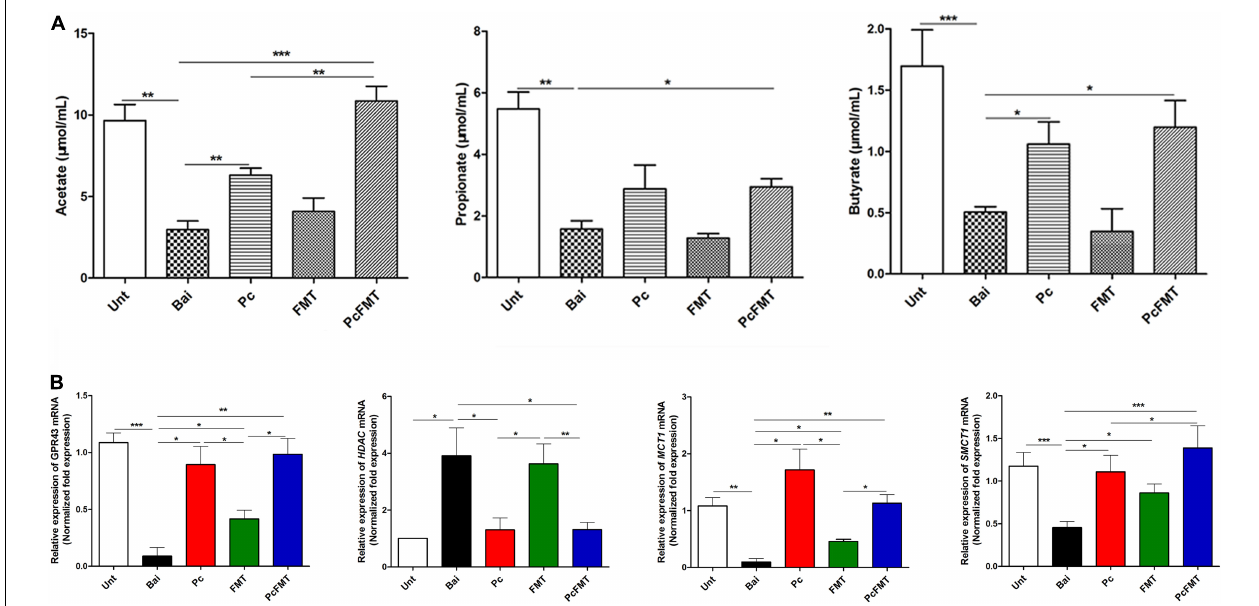
FIGURE 6 | SCFA concentrations and the relative expression of SCFA metabolism related genes. The colonic tissues and faeces were collected from healthy, bacterial-infected, single-dose Pc-treated, FMT-treated, and PcFMT-treated mice 48 h after S. Typhimurium (0.2 mL, 4 × 10 8 CFU/mouse) infection. (A) SCFA contents (acetate, propionate, butyrate) in the faeces of healthy, bacteria-infected, single-dose Pc-treated, FMT-treated, and PcFMT-treated mice. (B) The transcription levels of the SCFA transporters SMCT 1 and MCT 1 and the SCFA receptors HDAC and GPR 43 in the colonic tissues of different treatment groups. The relative expression was calculated as the ratio of the target gene to the internal reference genes ( β -actin and GAPDH ). Healthy mice were used as controls. Data are expressed as the means ± SEM, n = 6. * P < 0.05; ** P < 0.01; *** P <